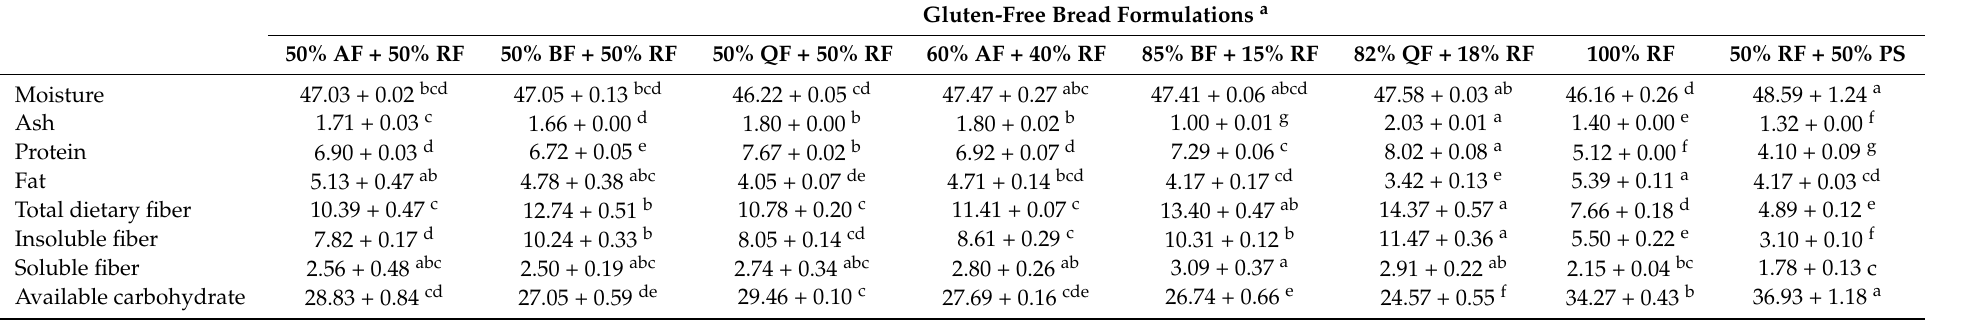
Table 3. Proximate composition of the selected gluten-free bread (GFB) formulations, compared with white GFB developed with rice flour (RF) and potato starch (PS) (g/100 g of food as